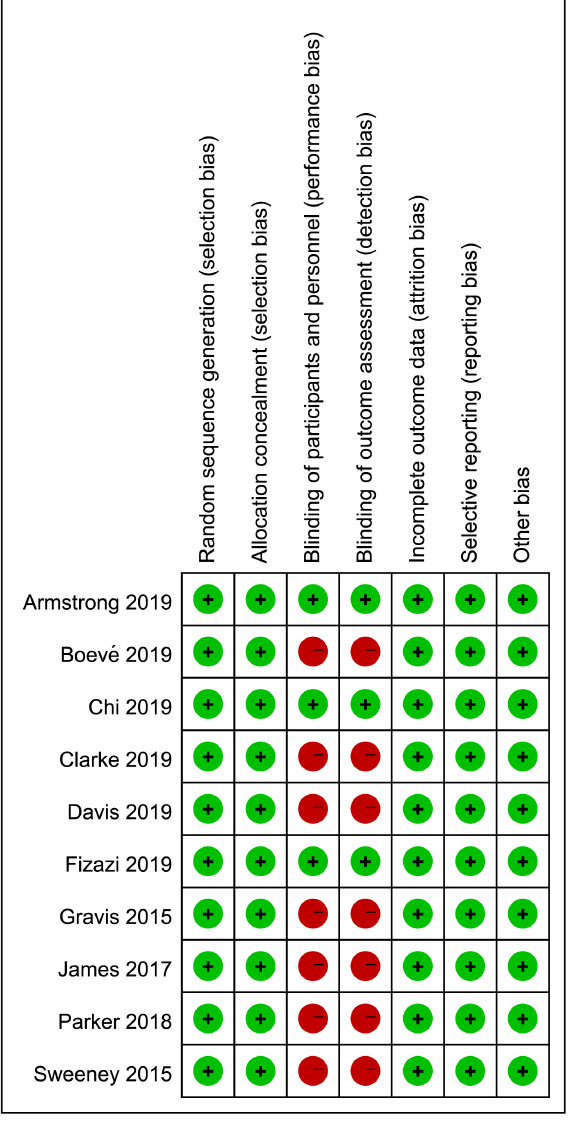
FIGURE 2 | Reviewers’ judgments of each risk of bias item for eligible